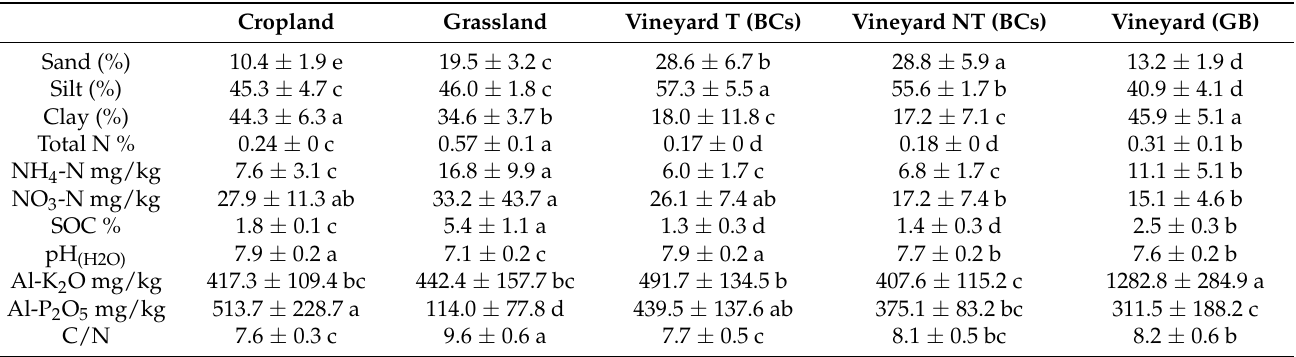
Table 1. Physical and chemical characteristics of the land use types investigated in the experiment.